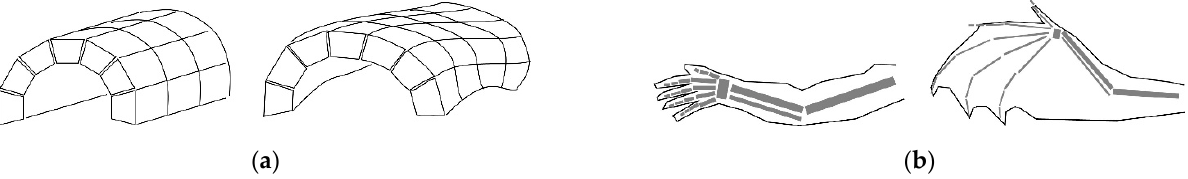
Figure 2. Seriality and body plans: ( a ) structures made from identical serial elements compared to structure made from serially produced similar elements (repetition with difference), ( b ) example of shared body plan—hand bones of a human and a bat.